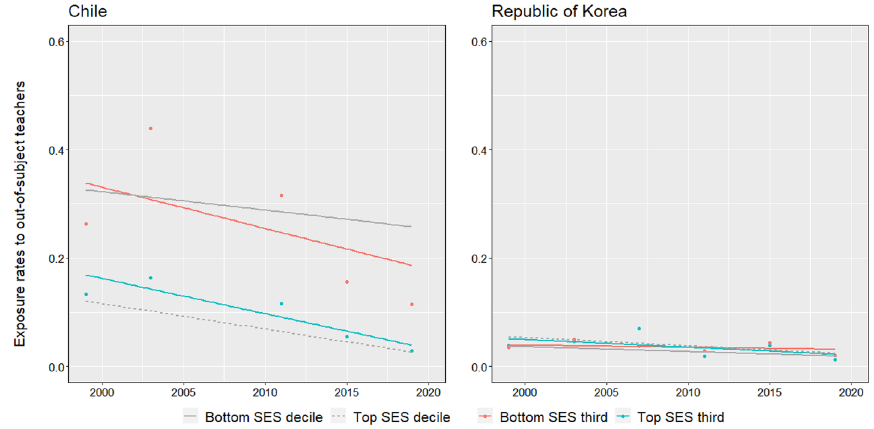
Fig. 2 20 year linear trends in out-of-subject teacher sorting for Chile and the Republic of Korea